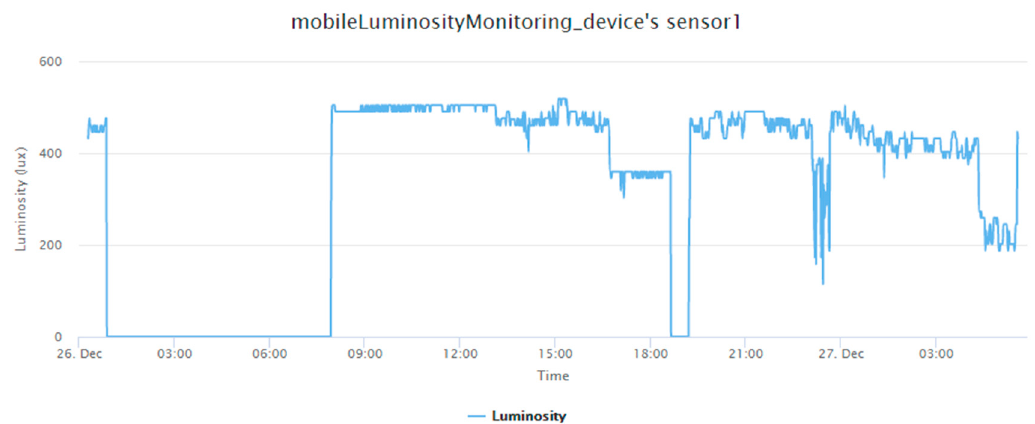
Figure 18. The luminosity observations of the mobile luminosity-monitoring device.